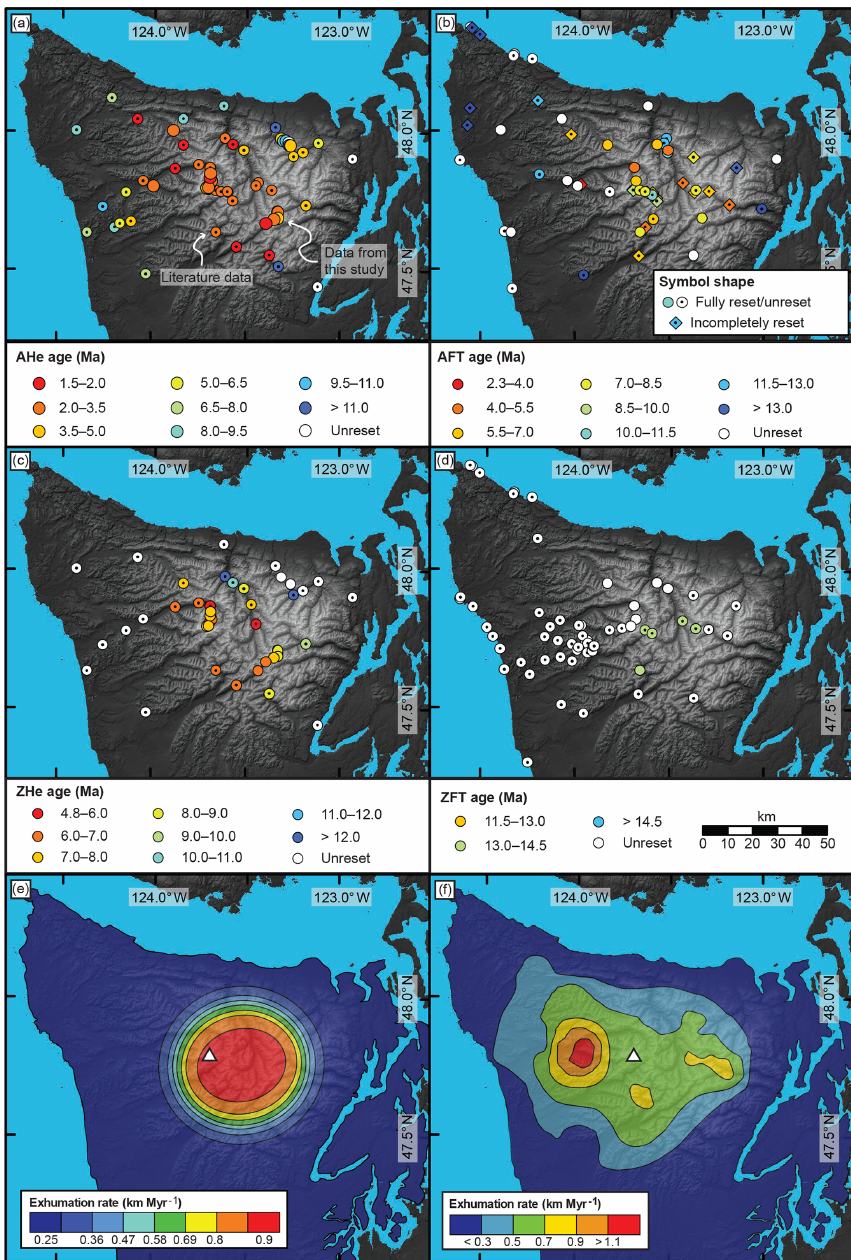
Figure 2. Map of new and previously published thermochronometric ages within the Olympic Mountains for (a) AHe, (b) AFT, (c) ZHe, and (d) ZFT. Data from the literature (Batt et al., 2001; Brandon et al., 1998; Brandon and Vance, 1992; Michel et al., 2018; Stewart and Brandon, 2004) are indicated by circles with a black dot. Note that the color coding of the symbols varies between panels. For AFT literature samples, the different reset states (fully reset, incompletely reset, and unreset) are indicated by symbol shape. Maps of exhumation rates as suggested by (e) Michel et al. (2018) and (f) Brandon et al. (1998). The white triangle denotes the location of Mt.